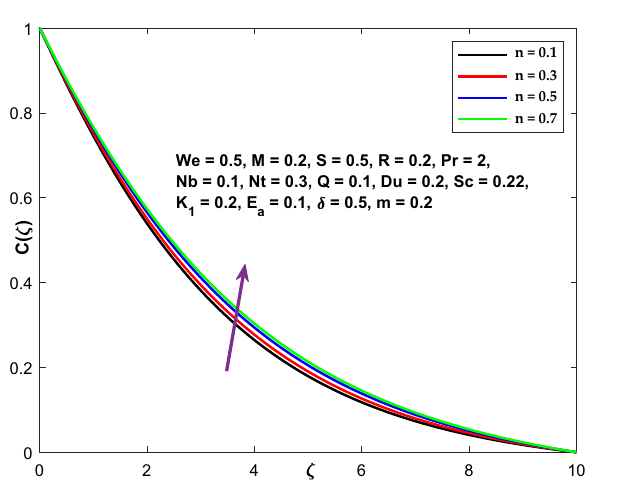
Figure 11. Character of n versus C (ζ) .